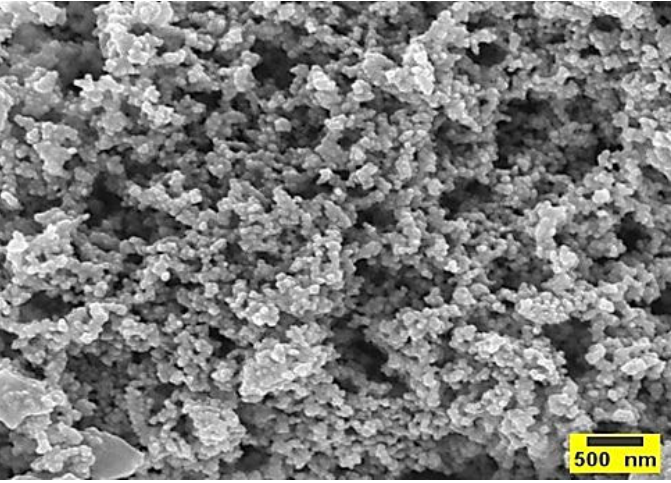
Figure 5. FE-SEM image of MgAl 2 O 4 NPs.